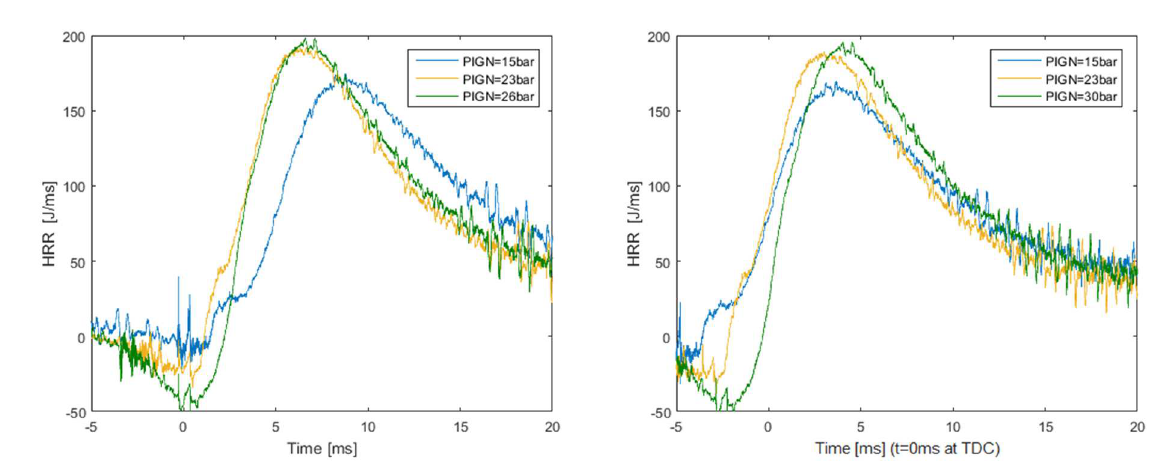
Fig. 4. Heat release rate for the representative cycles of the P ign variation plotted against time after ignition (left) and time after TDC